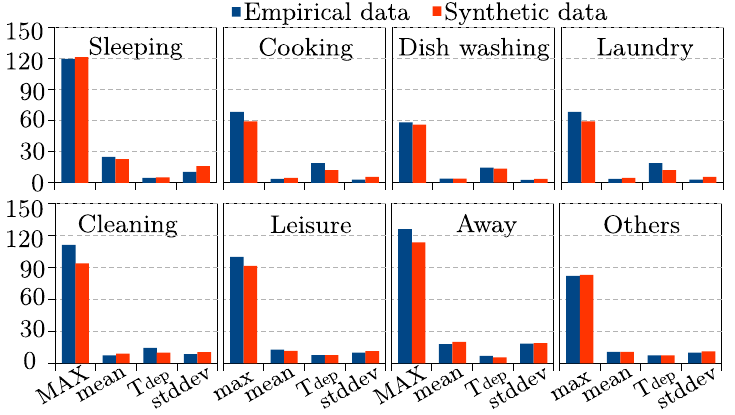
Figure 7. Comparison between time-dependence